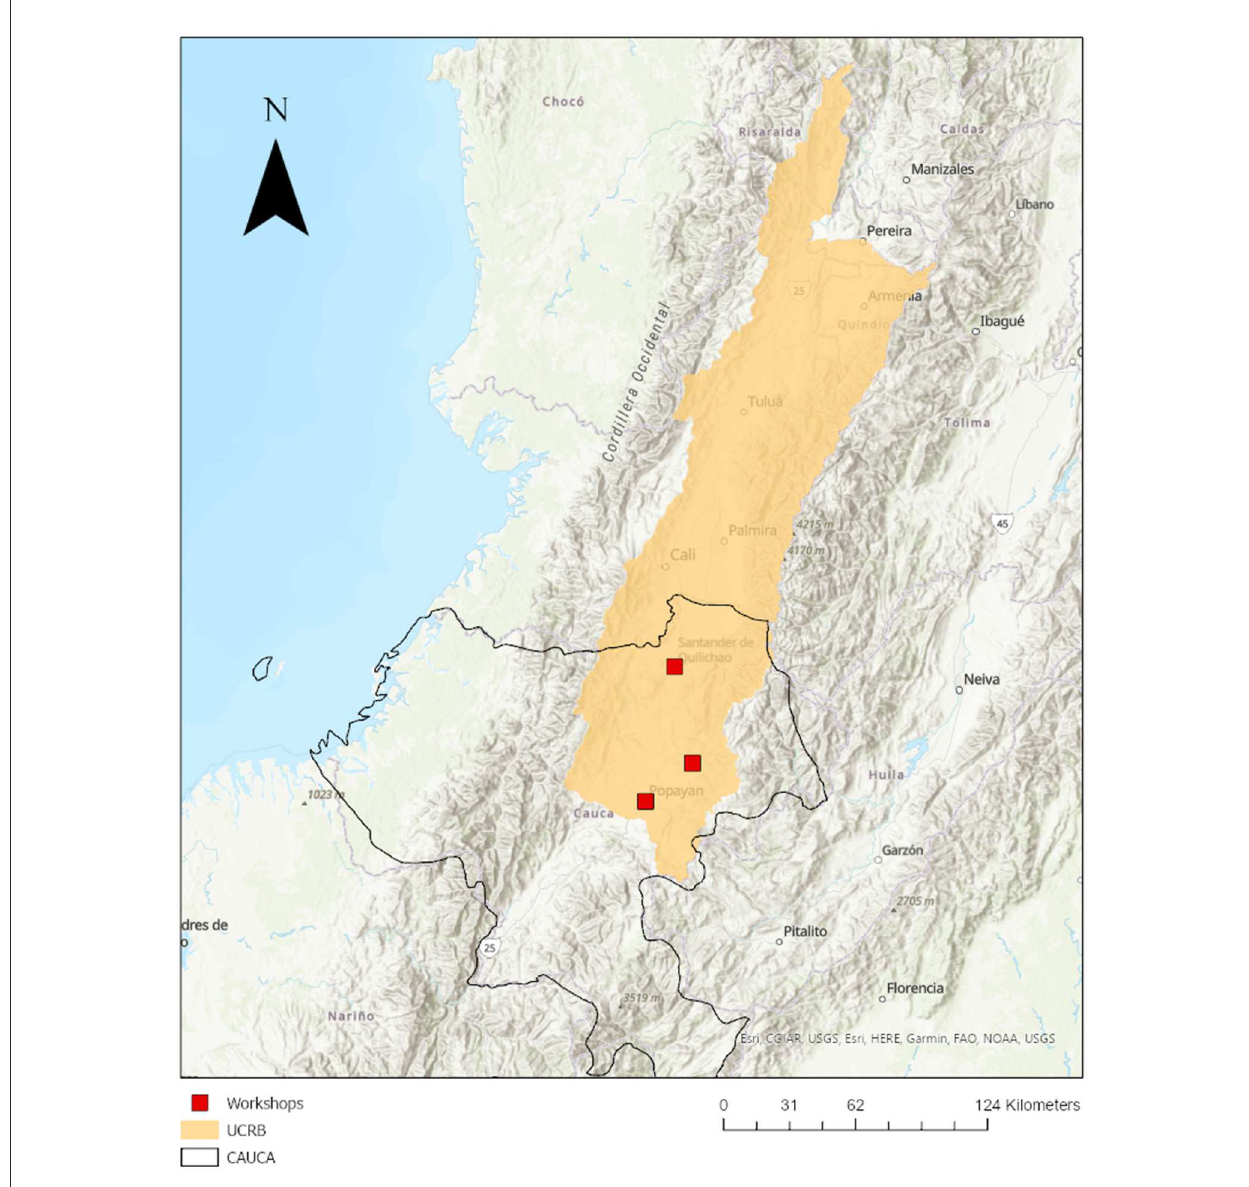
FIGURE1 UCRB and Cauca department location map.